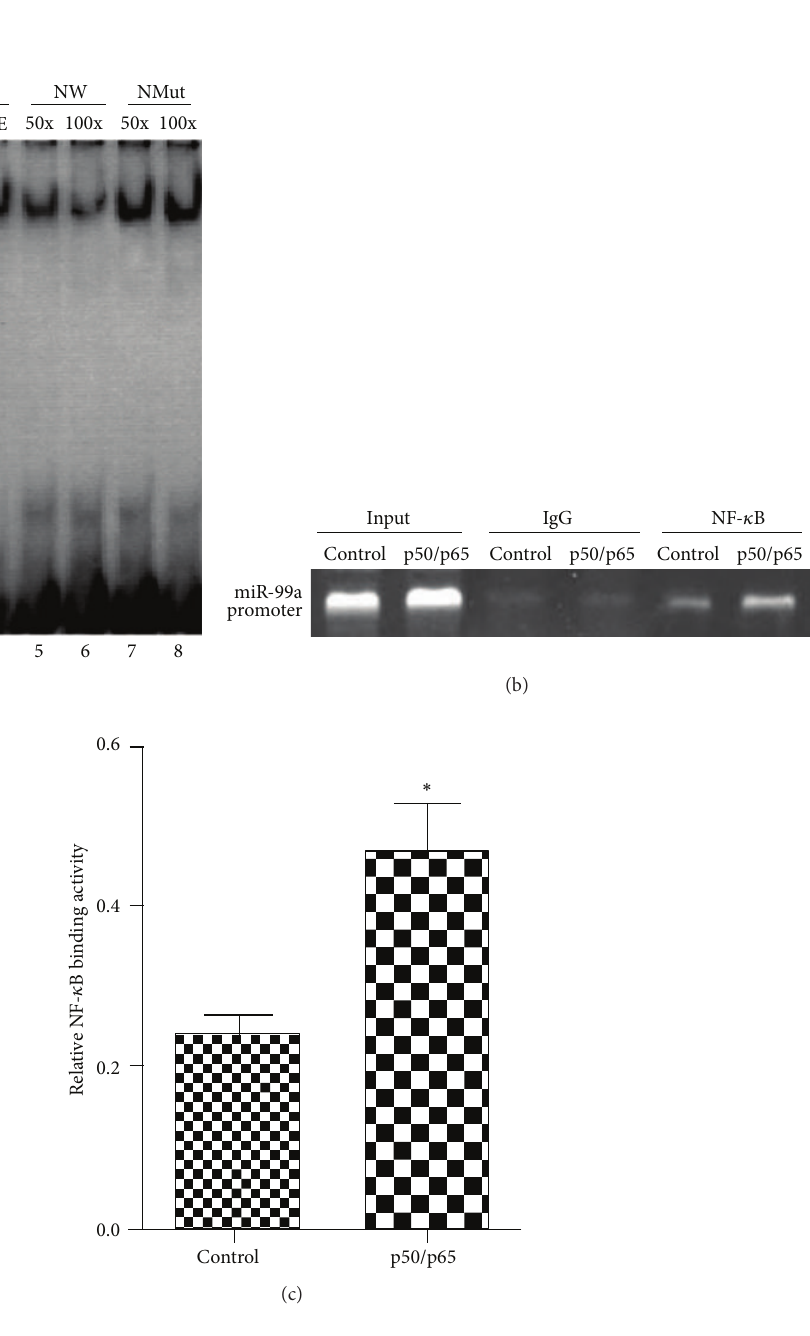
Figure 5: EMSA and ChIP verification of interactions of NF- 𝜅 B with its binding sites in the miR-99a promoter. (a) EMSA validation of NF- 𝜅 B binding sites on miR-99a promoter. Lane 1, labeled positive NF- 𝜅 B probe only; lane 2, nuclear extracts plus labeled positive NF- 𝜅 B probe; lane 3, labeled WT probe only; lane 4, nuclear extracts plus labeled WT probe; lanes 5 and 6, nuclear extracts plus labeled WT probe and cold unlabeled WT probe (50-fold and 100-fold labeled WT probe), respectively; lanes 7 and 8, nuclear extracts plus labeled WT probe and cold unlabeled Mut probe (50-fold and 100-fold labeled WT probe), respectively. NC: negative control; PC: positive control; NE: nuclear